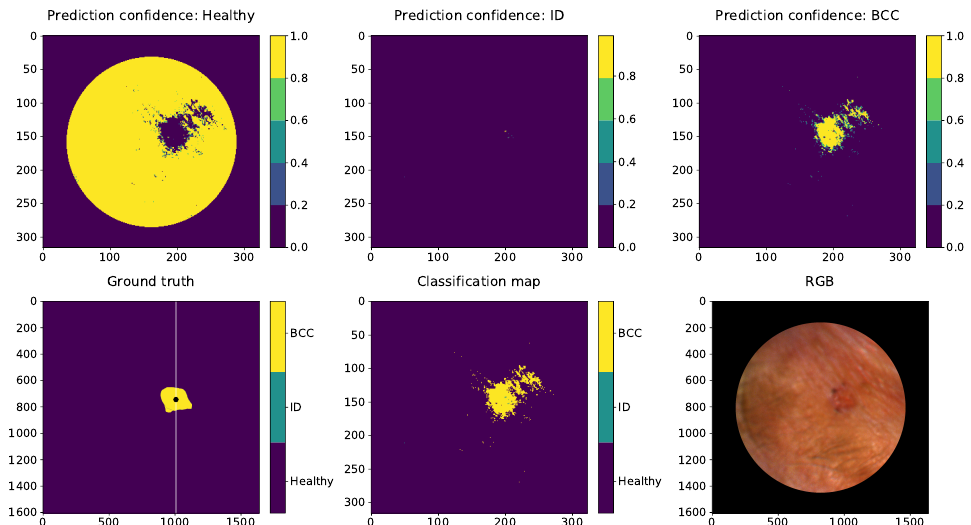
Figure 17. Nodular BCC visual pixel spectra classification example. First row: Healthy skin prediction confidence, prediction confidence of the ID and the prediction confidence of the BCC. Second row: The ground truth. The white line in the ground truth image shows the slicing position. The training data were collected as windowed (30 × 30 × 34) HS-sub-cubes. The middle pixels of those HS-sub-cubes (250 lesion and 100 healthy skin pixels) were randomly selected from the left sides of the lesions. We can see from the classification map (middle) that the nodular lesion is delineated relatively well, but some miss-classified pixels can be seen above the right upper corner of the lesion. The “RGB” illustration of the lesion is on the right. The lesion was captured from the left corner of the eye. The unit of measures is smaller with prediction maps since the HS images were windowed with 5 pixels step.